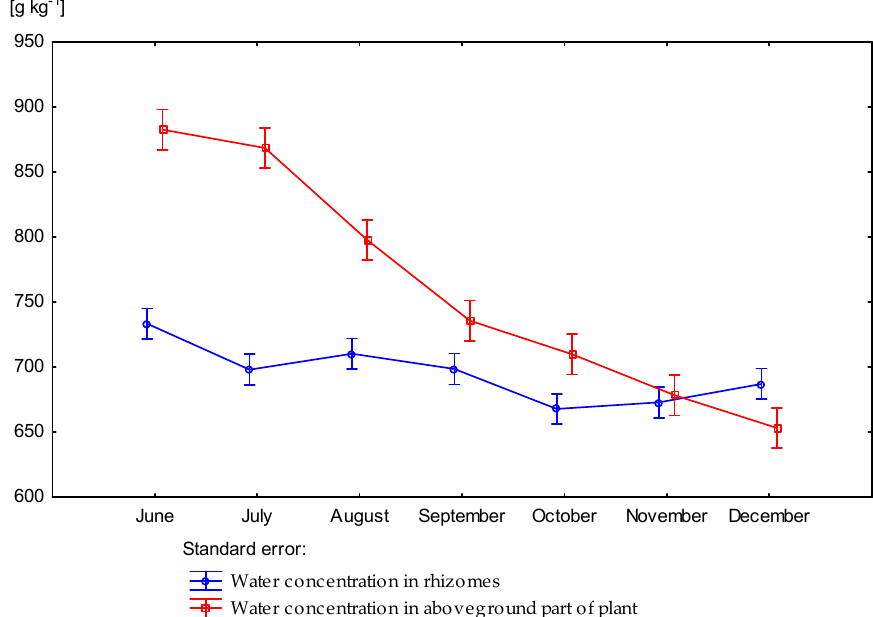
Figure 6. Water concentration in the rhizomes and aboveground part of plants during the vegetation period of the years 2014–2016 (average for years).